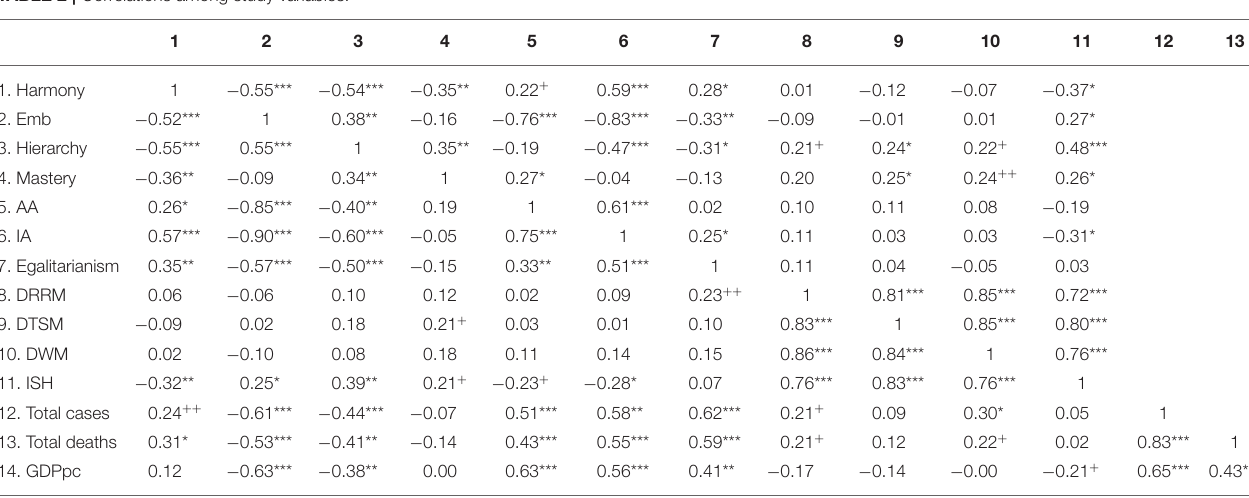
TABLE 2 | Correlations among study